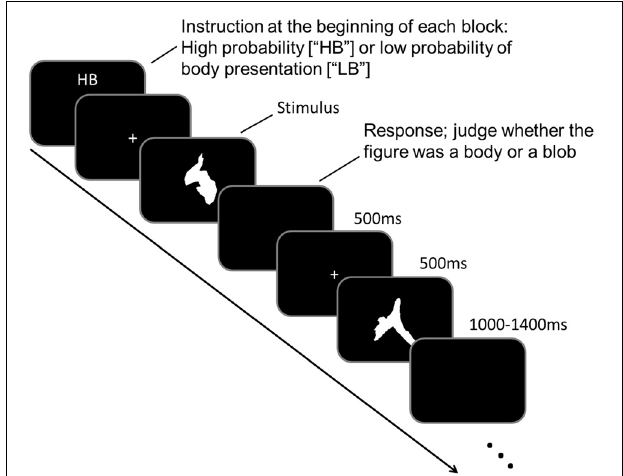
FIGURE 1 | An illustration of the paradigm and examples of the stimuli used in this study.